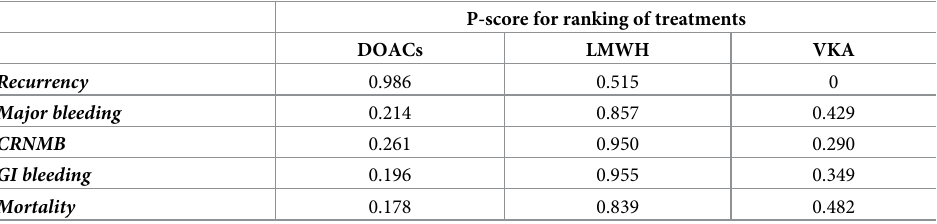
Table 3. Ranking of treatments according to network